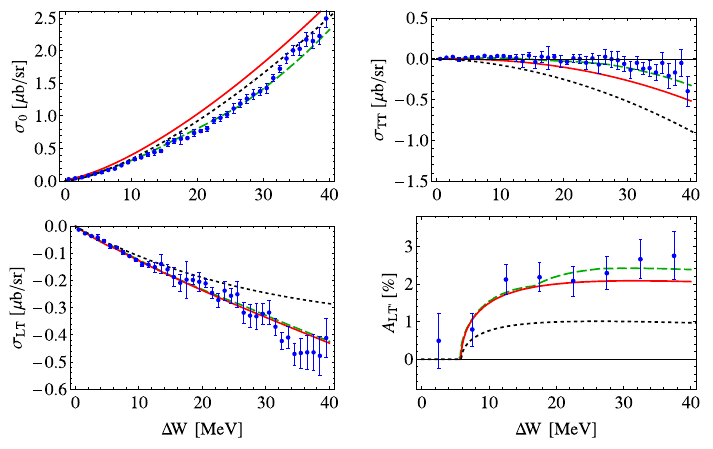
Figure 3. Coincidence cross sections (cid:3) 0 , (cid:3) TT , and (cid:3) LT in (cid:5) b/sr and beam asymmetry A LT (cid:3) in % at constant = 90 ◦ , (cid:4) = 90 ◦ , and (cid:1) = 0.93 as a function of (cid:5) W above threshold. The solid (red) lines Q 2 = 0.05 GeV 2 , (cid:6) (cid:1) (cid:1) show our RChPT calculations at O ( q 4 ) and the dotted (black) lines are the heavy-baryon ChPT calculations of Ref. [11]. The dashed (green) curves are obtained from the DMT model [4]. The data are from Ref.